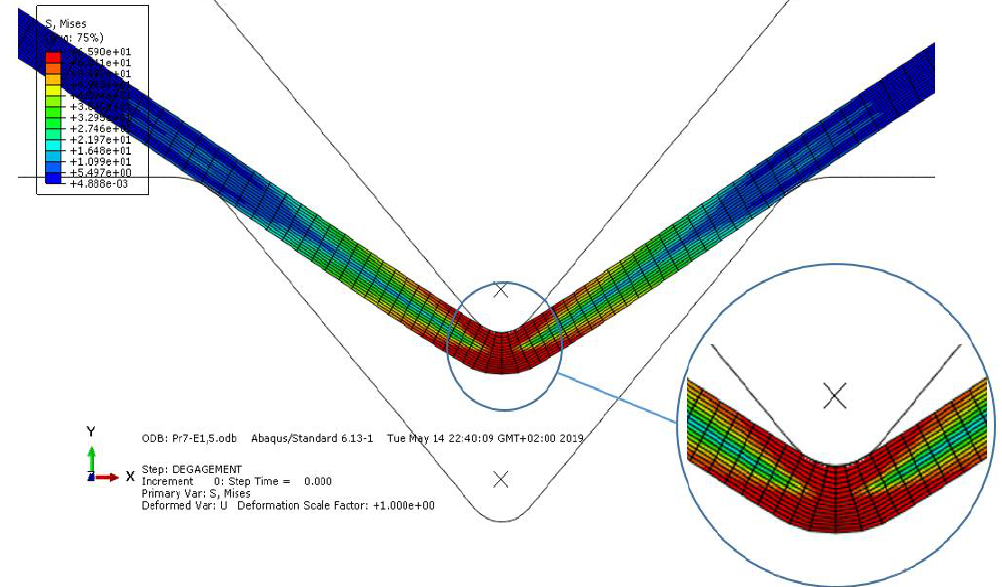
Fig. 5. The nodes of the upper